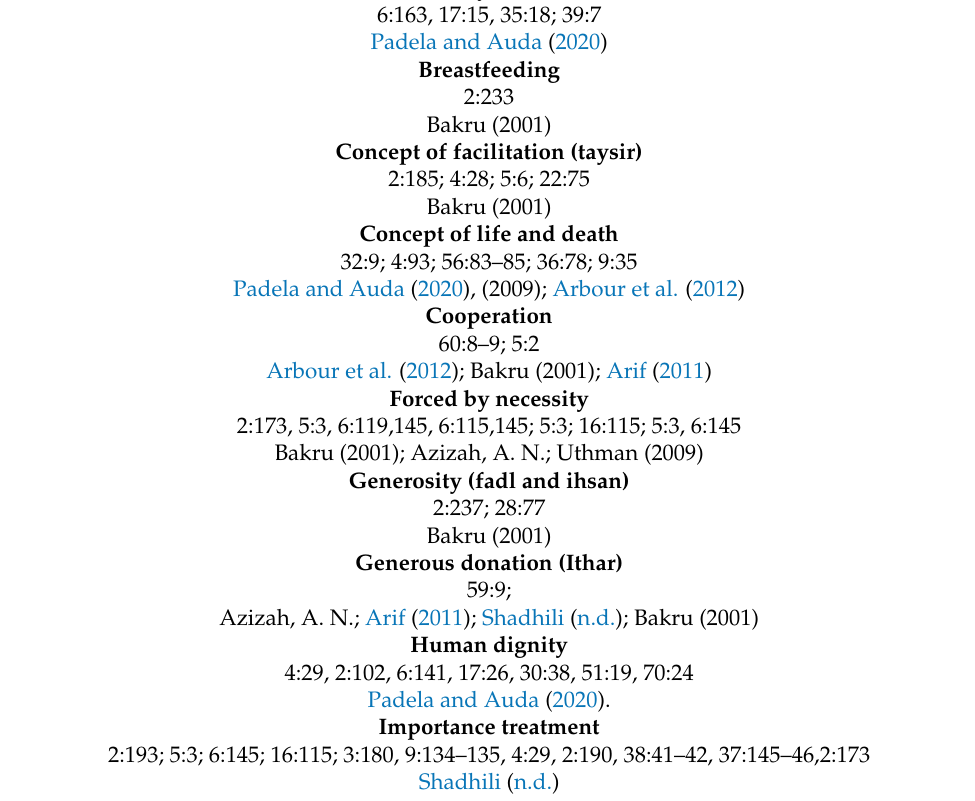
Table 1. Quranic verses used in the literature and their theoretical